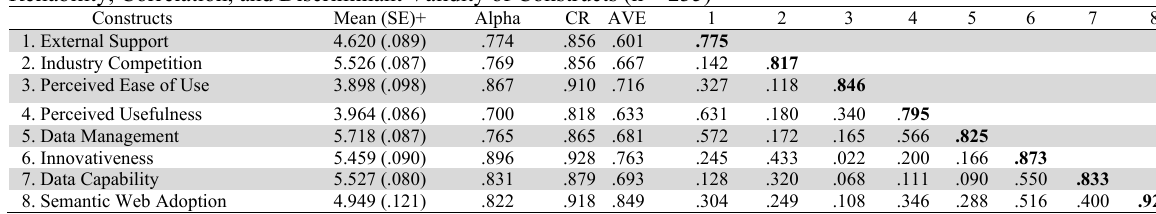
Reliability, Correlation, and Discriminant Validity of Constructs (n = 235)